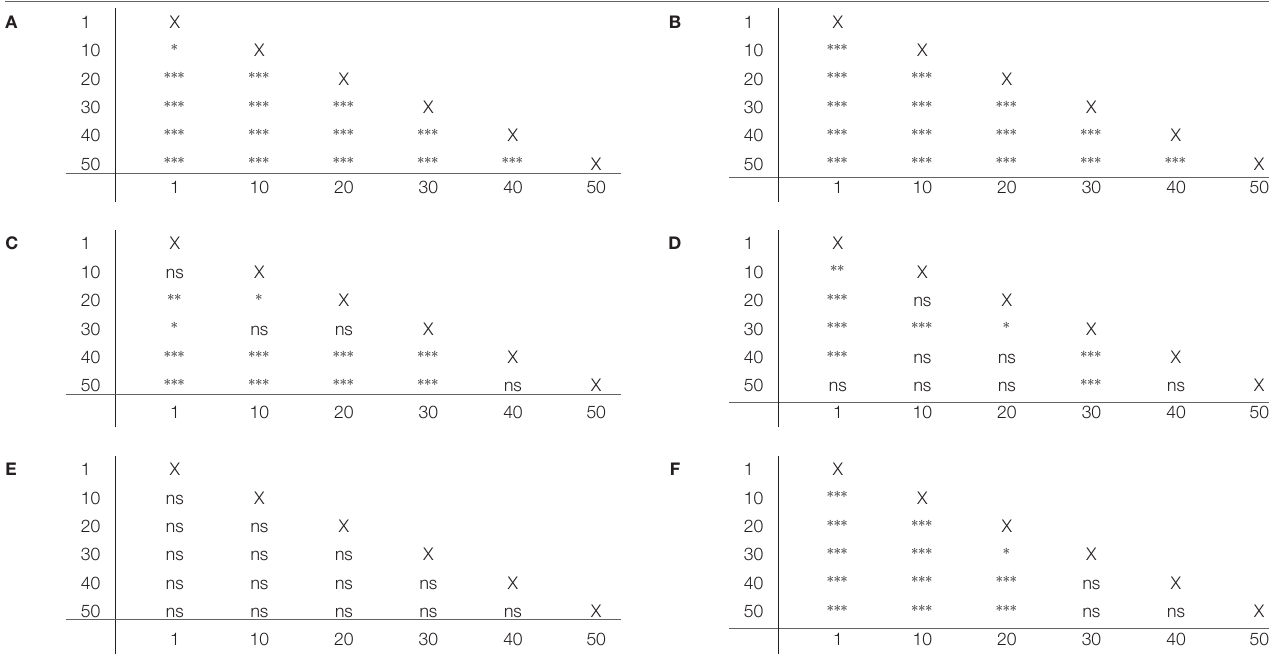
TABLE 3 | Pairwise comparison of 6 environmental parameters between water depths